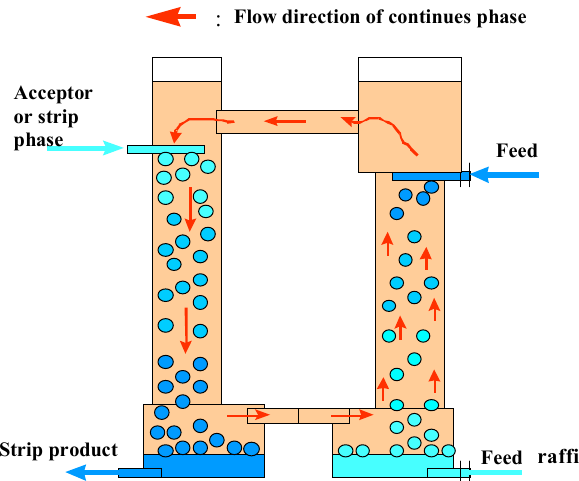
Figure 2. Schematic arrangement of the three-phase extraction apparatus.